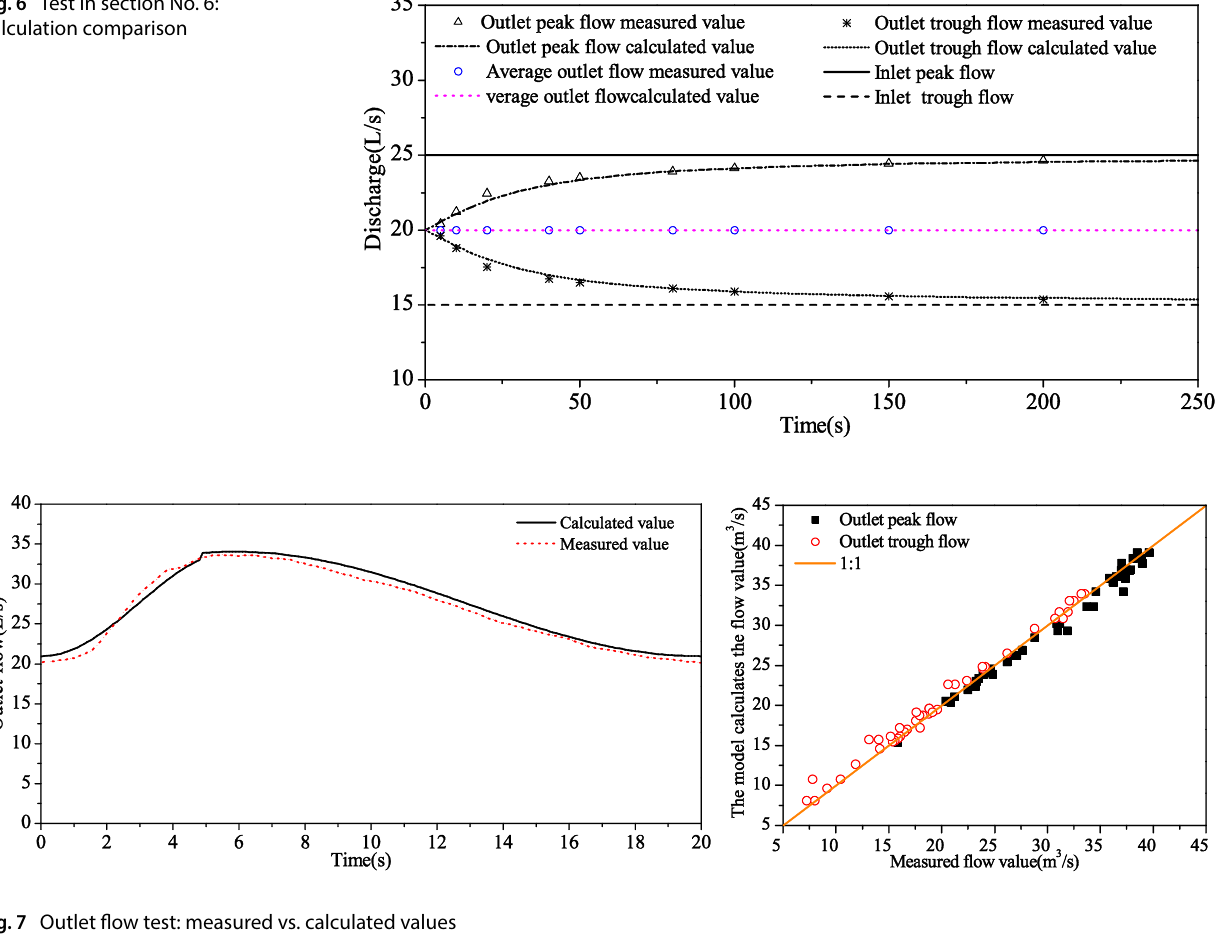
Fig. 6 Test in section No. 6: calculation comparison